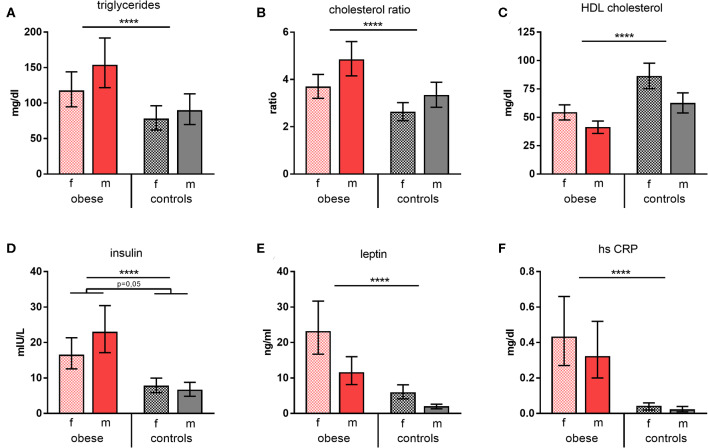
Metabolic and inflammatory parameters. Concentrations/values of (A) triglycerides (mg/dl), (B) cholesterol ratios, (C) HDL cholesterol (mg/dl), (D) insulin (mIU/L), (E) leptin (ng/ml), and (F) high-sensitive CRP (mg/dl) as geometric means (GM) with 95% CI; cholesterol ratio was calculated as total cholesterol/HDL cholesterol; values for females (f) and males (m). ANOVA with linear contrasts; ****p ≤ 0.0001.